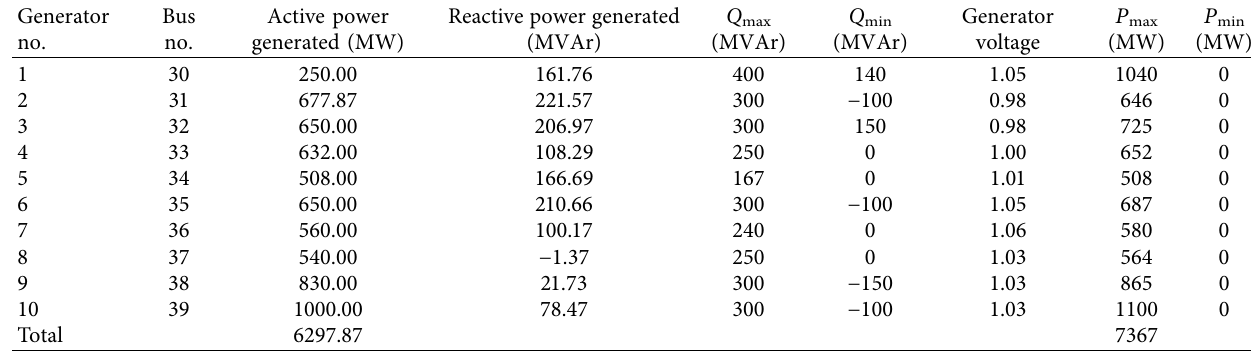
Table 13: Generator data